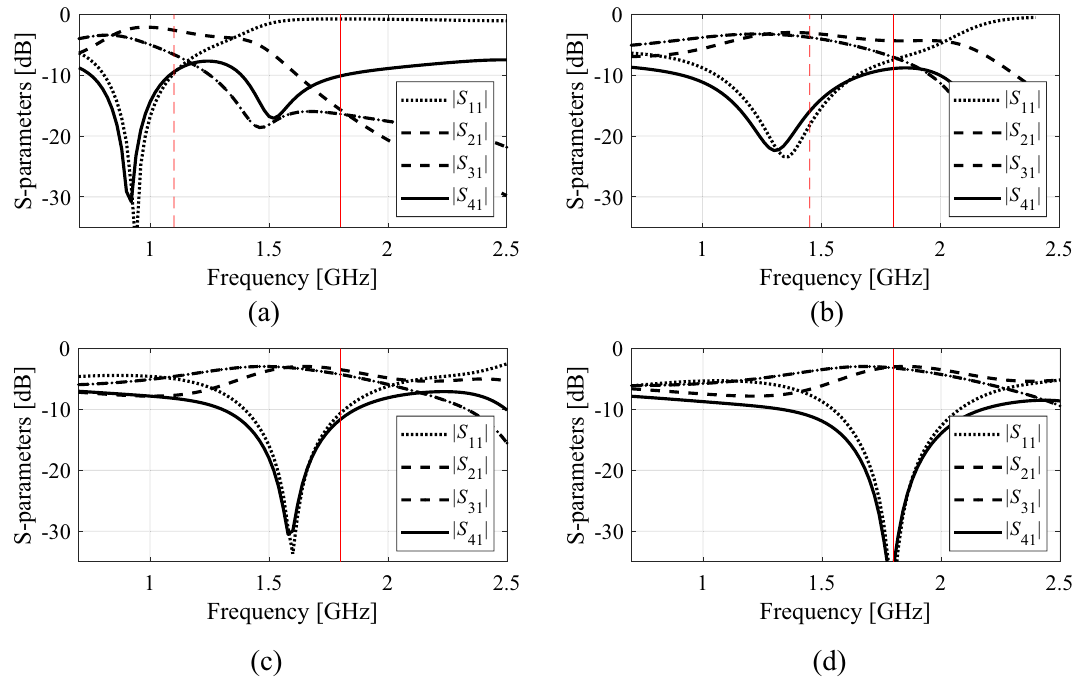
Figure 2. The concept of the design requirement adjustment on the example of a branch-line coupler of Fig. 1. The starting point (marked gray) and the intended operating frequency (marked using vertical line) are identical to that of Fig. 1: ( a ) target frequency shifted near the actual operating frequency of the initial design to make sure that the ongoing specifications (dashed line) may be reached from this very design, ( b ) intermediate step with the current design and specs shown, ( c ) ultimate optimization step: the intended operating frequency restored to its assumed value, ( d ) final design meeting the original requirements.